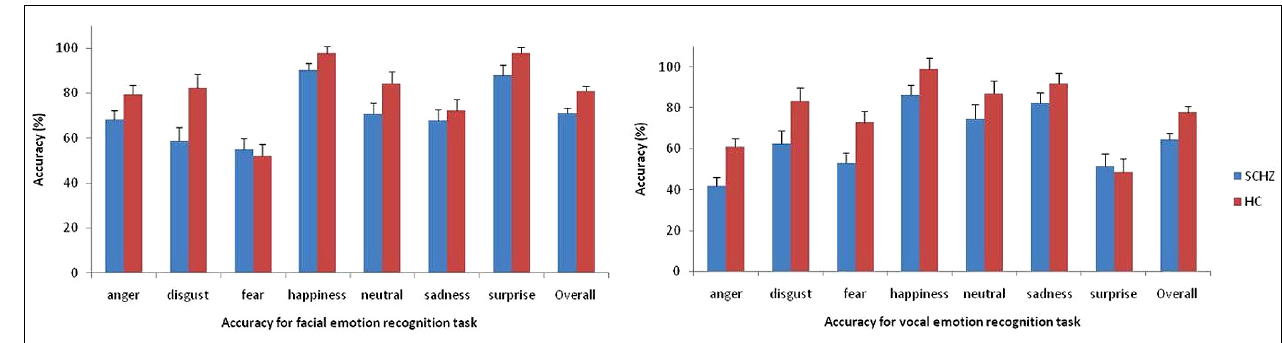
FIGURE 2 |Accuracy in percentage of correct responses for facial and vocal emotion recognition task. Error bars indicate standard errors of